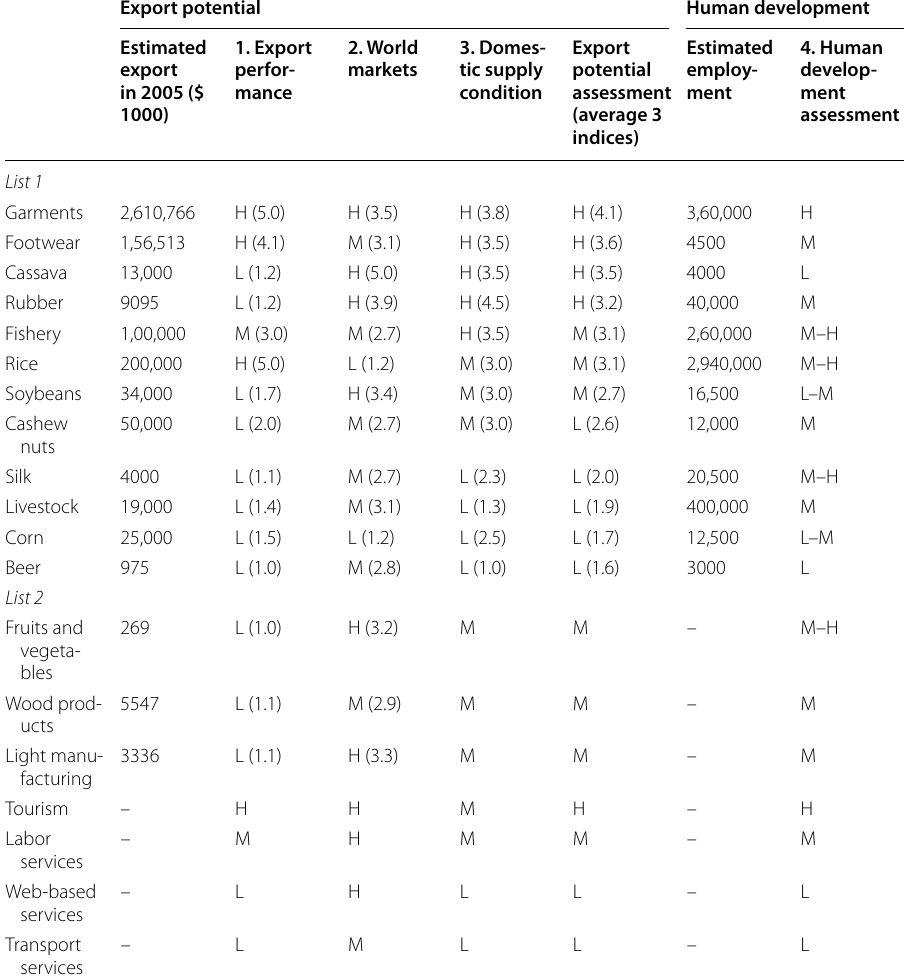
Table 9 Positioning levels of the 19 products and services. Source : MoC